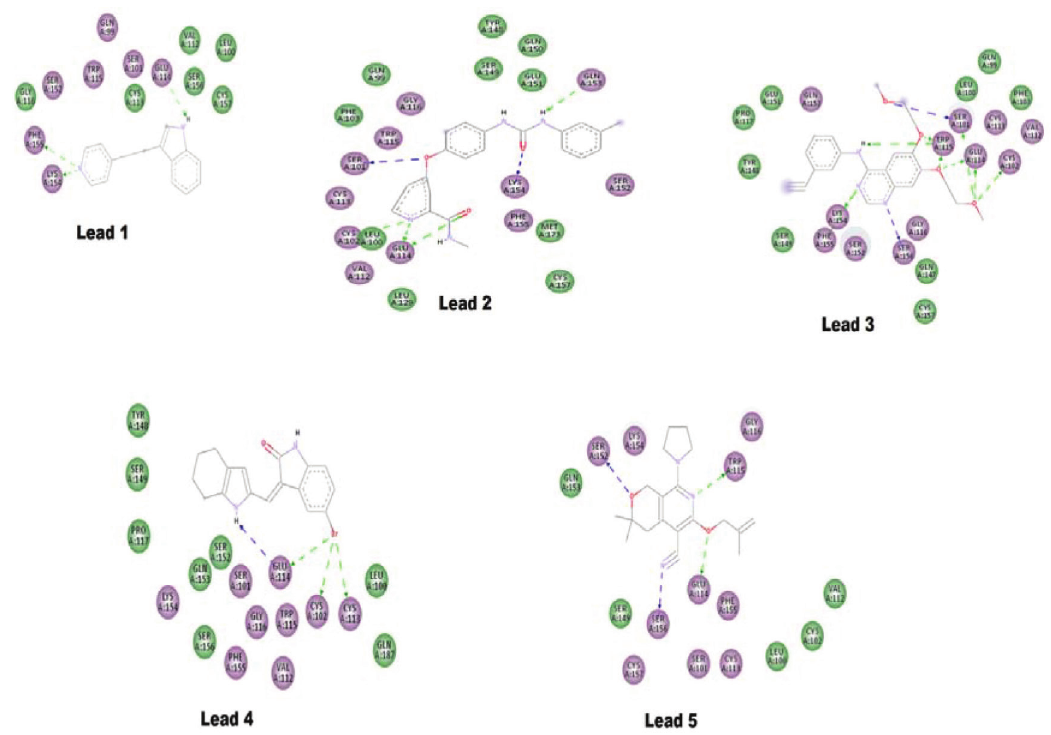
FIGURE 4 - Two dimensional representations of the top five compounds showing the physical interaction with the binding site of